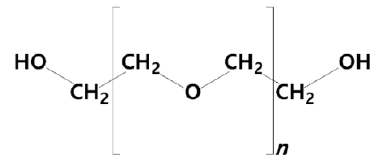
Figure 3. Chemical formula of PEG.